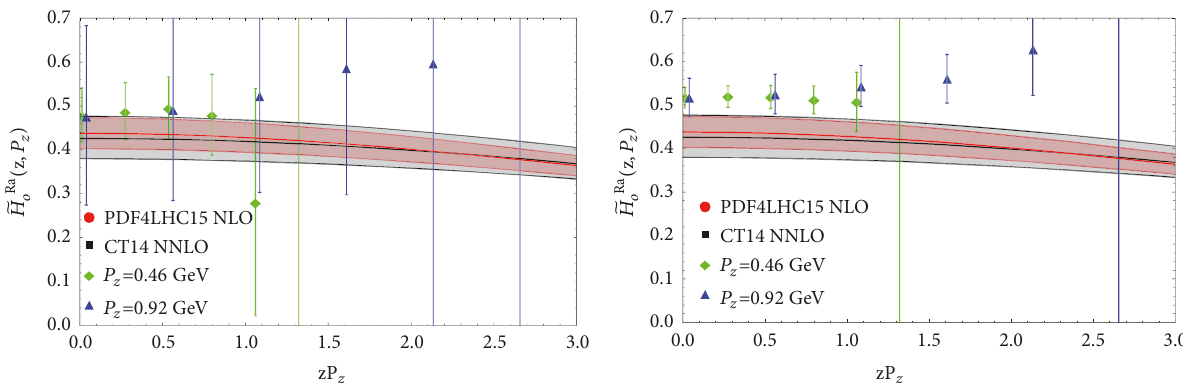
Figure 31: “Ratio-renormalized” matrix elements of the operator O 0 defining gluon quasi-PDFs in the study of [229]. Nucleon momenta are 0.46 and 0.92 GeV. Valence pion mass of 340 MeV (left) and 678 MeV (right). Also plotted are inverse Fourier transforms of two phenomenological fits to experimental data: CT14 [210] and PDF4LHC15 [24]. Source: [229] (arXiv), reprinted with permission by the